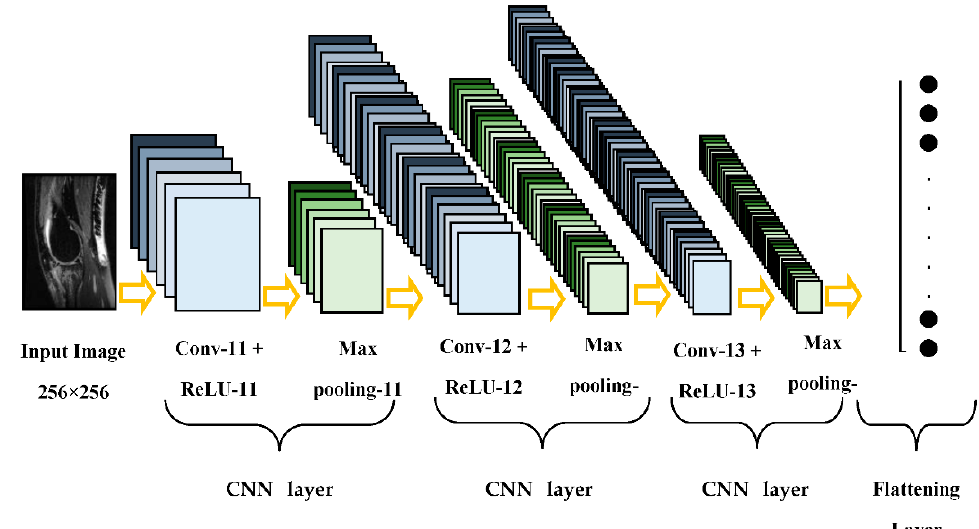
Figure 2. Representation of the first parallel layer of the proposed scheme.